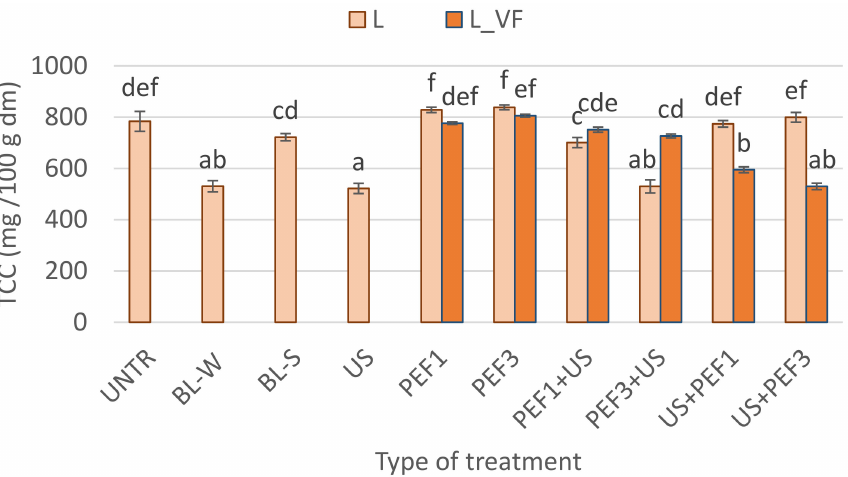
Figure 5. Total carotenoids content (TCC) in lyophilized red bell peppers treaded with tradi- tional treatment (BL_W—blanching in water, BL_S—steam blanching), novel single treatment (US— sonication for 30 min, PEF_1—pulsed electric field with energy input 1 kJ/kg, PEF_3—pulsed electric field with energy input 3 kJ/kg) or novel hybrid treatment (PEF+US, US+PEF), preceded by shock freezing (L) and vacuum freezing (L_VF). Data are presented as a mean from 3 repetitions with error bars as a standard deviation (SD), data with different letters differ significantly (Tukey’s HSD, p <